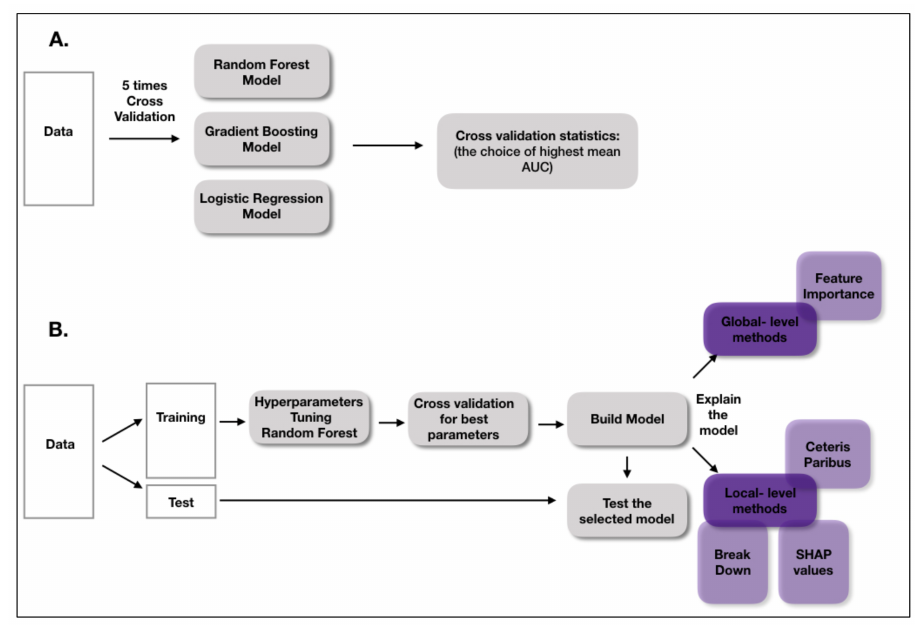
Figure 1. A workflow diagram. ( A ) This part presents how the best model was chosen. ( B ) The workflow of building and explaining the final model. Results are available at: https://stats4med. shinyapps.io/xai2shiny/ (accessed on 8 June